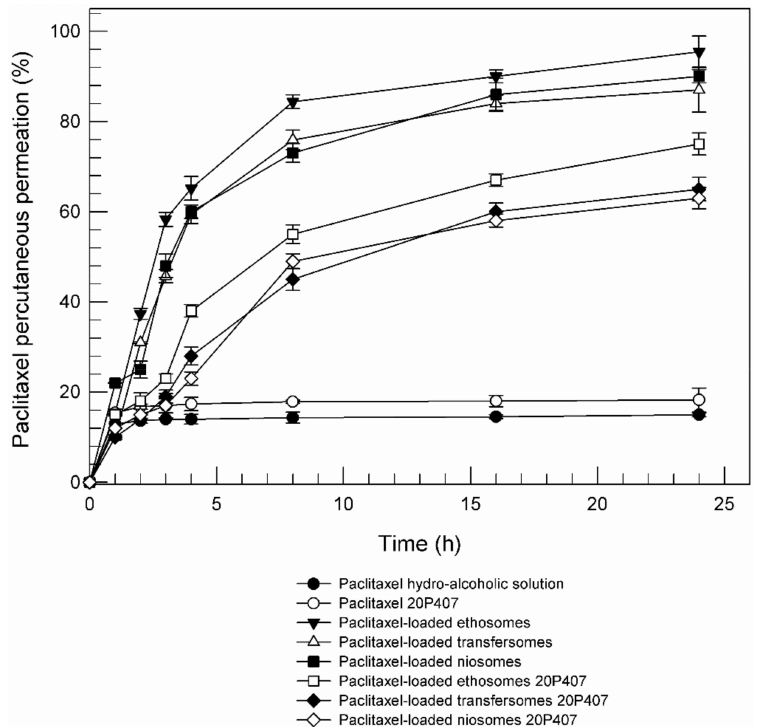
Figure 9. In vitro percutaneous permeation of paclitaxel from di ff erent formulations through SCE membranes, in comparison with a hydroalcoholic drug solution (as the control). Values represent the mean of three di ff erent experiments ± standard